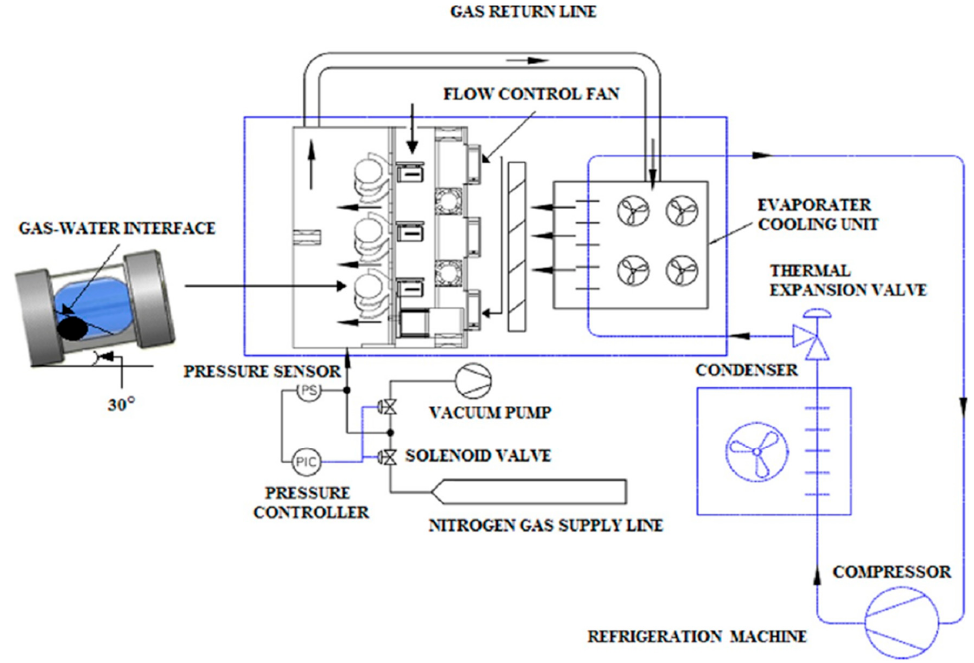
Figure 1. Experimental schematic diagram of rocking cell hydrate reactor [42].